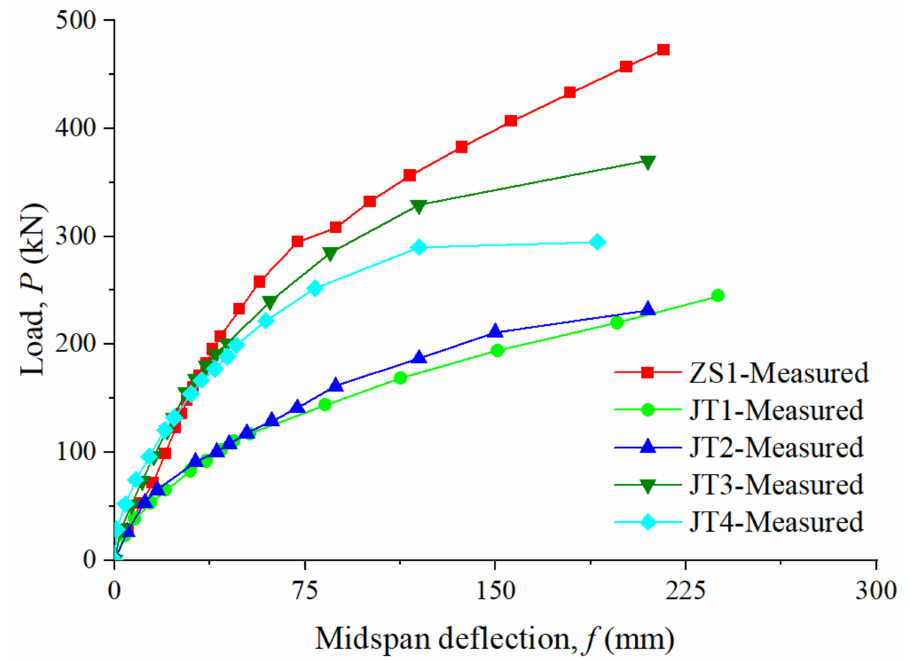
Figure 8. Load-midspan deflection curves of bending